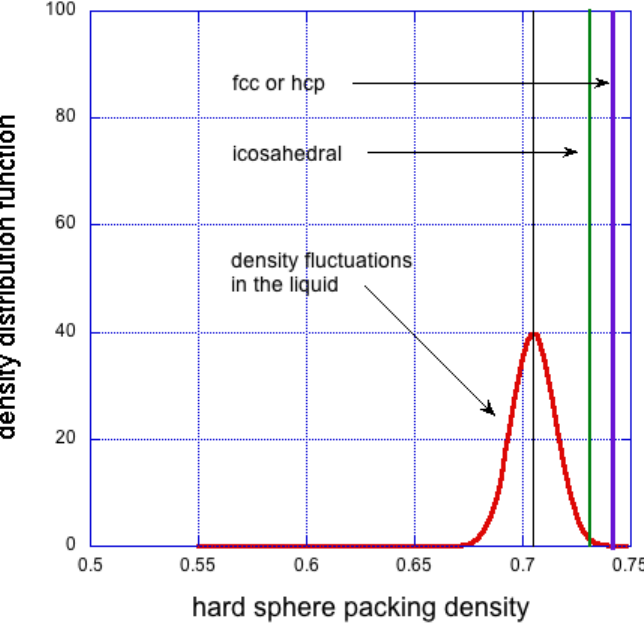
Figure 4. Expected density fluctuations in liquid phase (red). Also shown is approximate density of icosahedral cluster (green) and singular density of fcc crystalline solid (blue). The average density of the liquid is chosen to be 5% less than that of the fcc